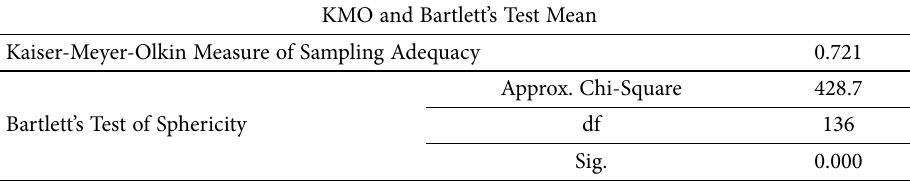
Table 4. Kaiser-Meyer-Olkin measure of sampling adequacy and Bartlett’s test KMO and Bartlett’s Test